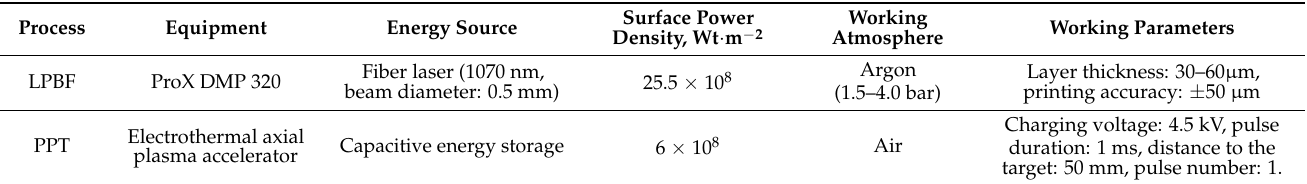
Table 1. Process (LPBF) and post-process (PPT)